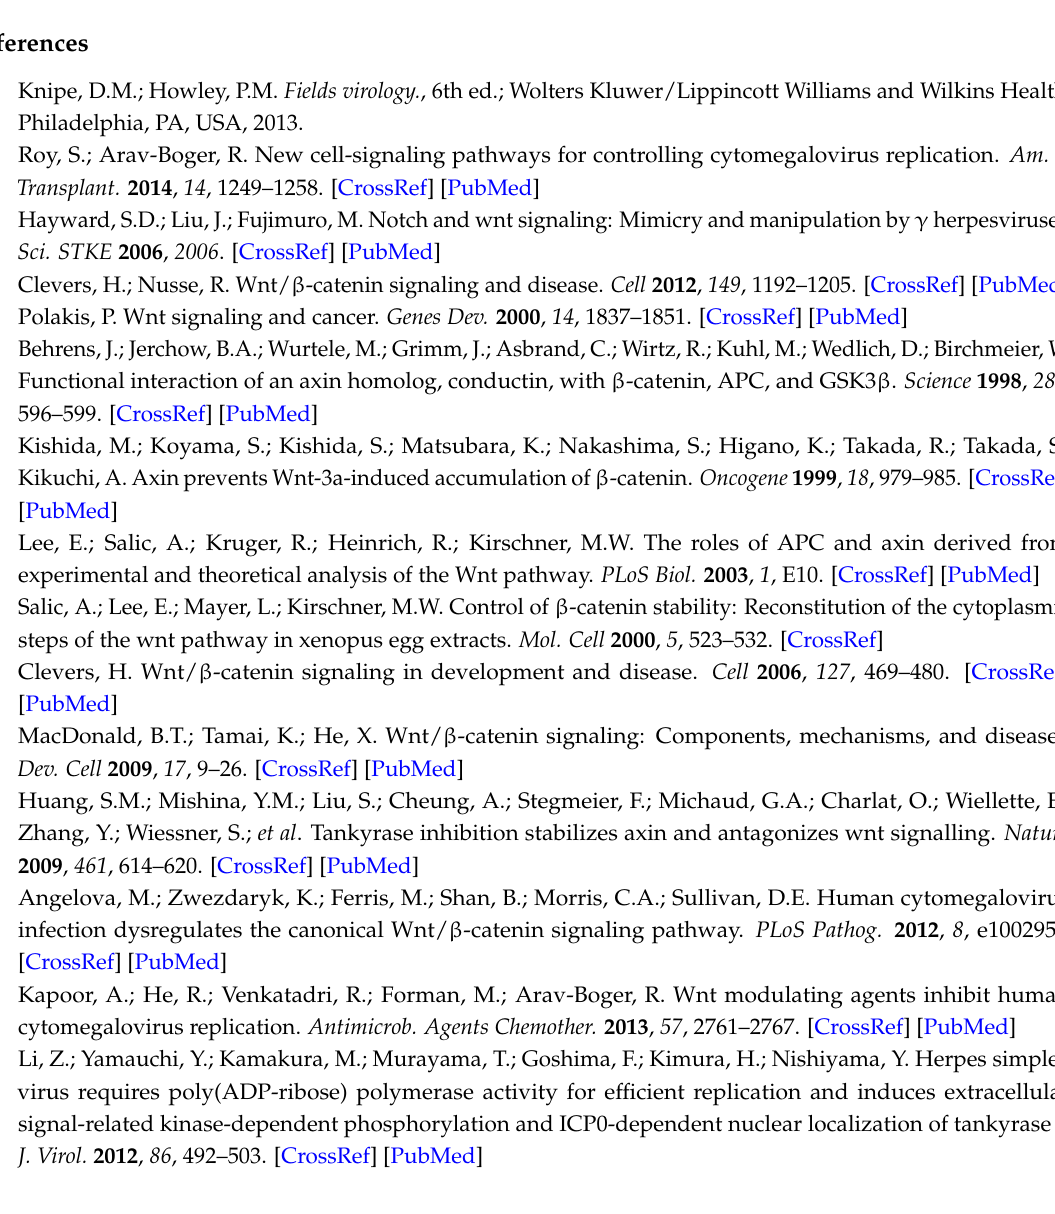
Figure S1: XAV939 does not induce PARP1 or PARP2 transcription, Figure S2: Growth of TB40 is enhanced in